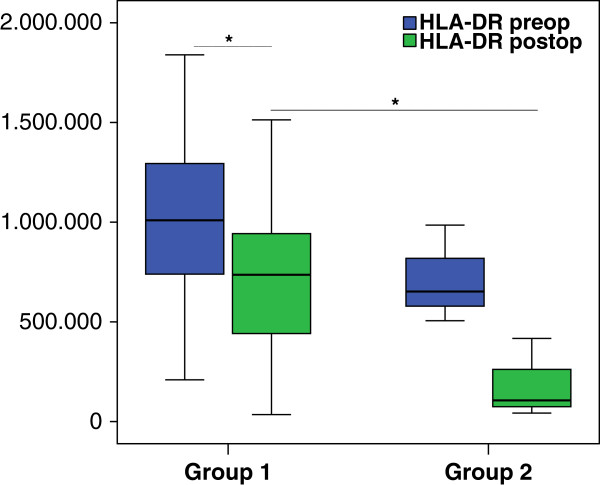
Human leukocyte antigen-DR (HLA-DR) expression on alveolar macrophages (AMs). HLA-DR expression on AM in group 1 (n = 28) showed a significant reduction after surgery (P = 0.002). In group 2 (n = 3), HLA-DR expression was highly diminished after surgery not possible to calculate P value with only 3 patients. Comparing both groups the baseline had a tendency to be lower (P = 0.20) and the postoperative HLA-DR expression was significantly reduced in group 2 (P = 0.024). Box plots represent median and IQR; blue, values before surgery; green, values after surgery. The Wilcoxon test was used for dependent groups and the Mann–Whitney U-test for independent groups; *P <0.05.